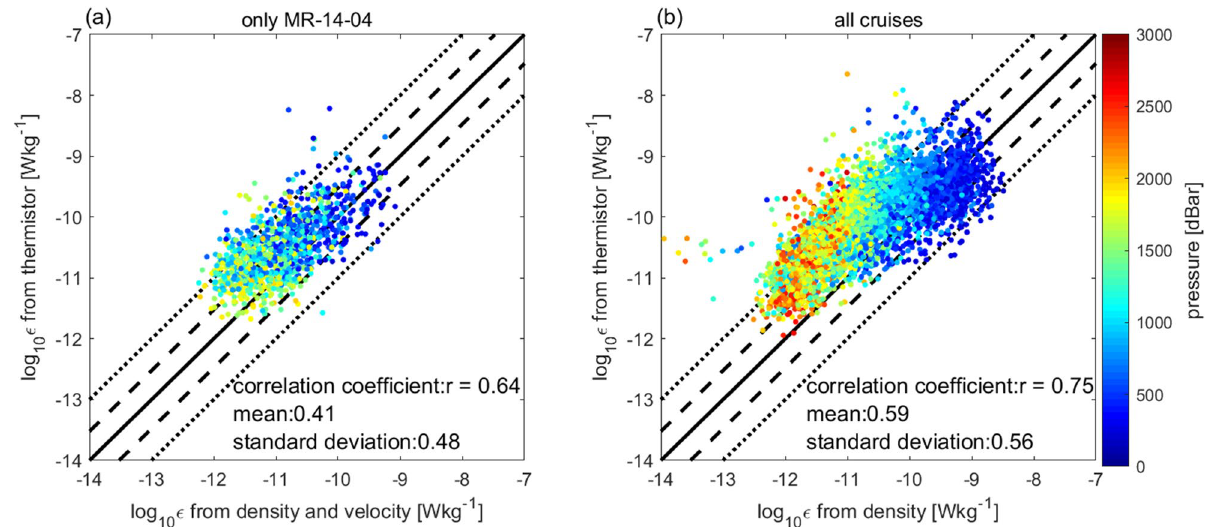
Figure 4. Comparison of ε with fine-scale parameterizations. ( a ) ε based on fine-scale velocity and density using Lowered Acoustic Doppler Current Profilers (LADCP) and CTD 10 . ( b ) ε based on only fine-scale density 8 . Data are averaged in 320-m segments. The surface data that included the upper 100-m layer are not used. In ( a ), data with pressure > 2000 dbar are excluded because the accuracy of the measurement of LADCP is low in the deep ocean. In ( b ), data with N 2 < 10 –6 s −2 are excluded since the estimation of the vertical gradient of density is difficult in the low stratified regions. “mean” and “standard deviation” in the legend represent the average and the standard deviation of log(Y/X),